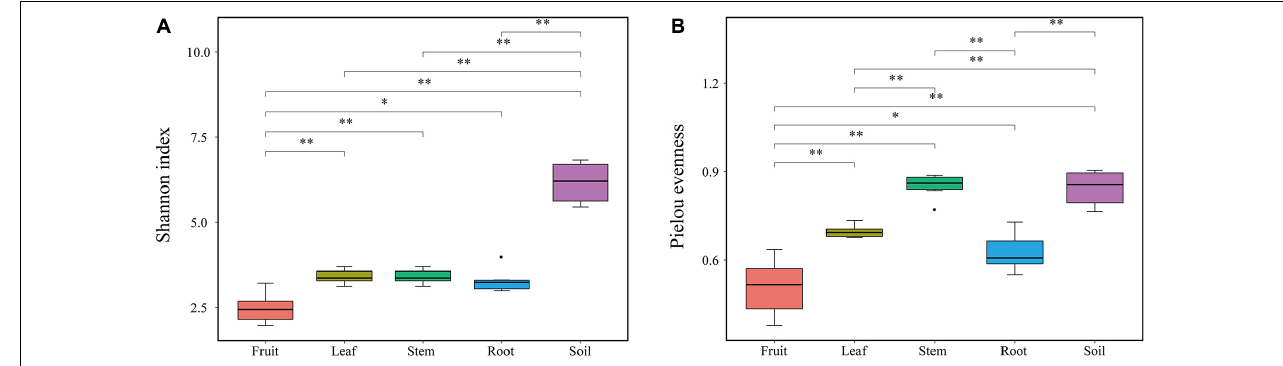
FIGURE 1 | Diversity indexes of endophytic bacterial communities. (A) Shannon index (B) Pielou’s evenness.